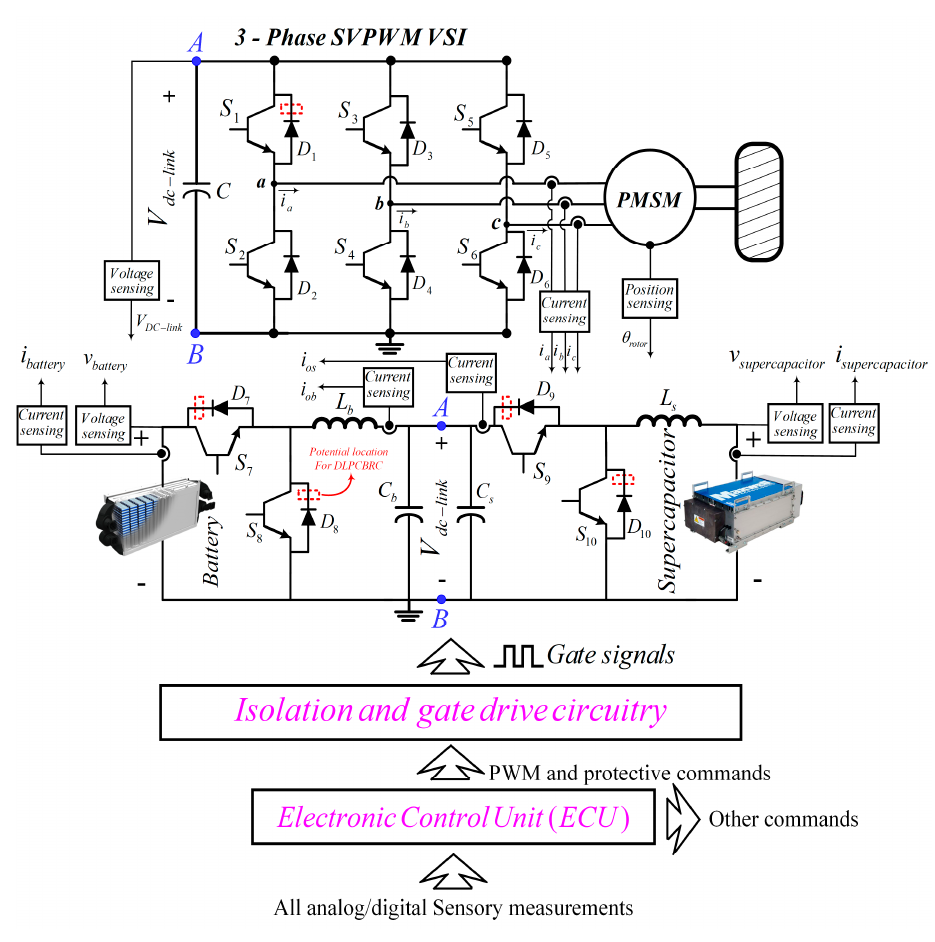
Figure 1. Electrical block diagram of the EV drivetrain.